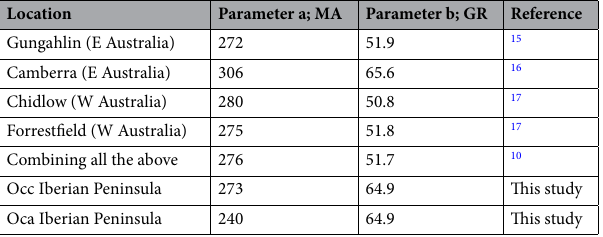
Table 2. Constants determined for the relationships between rabbit age and lens dry weight in this (Model 4) and previous studies. MA maximum asymptotic value, GR growth rate.